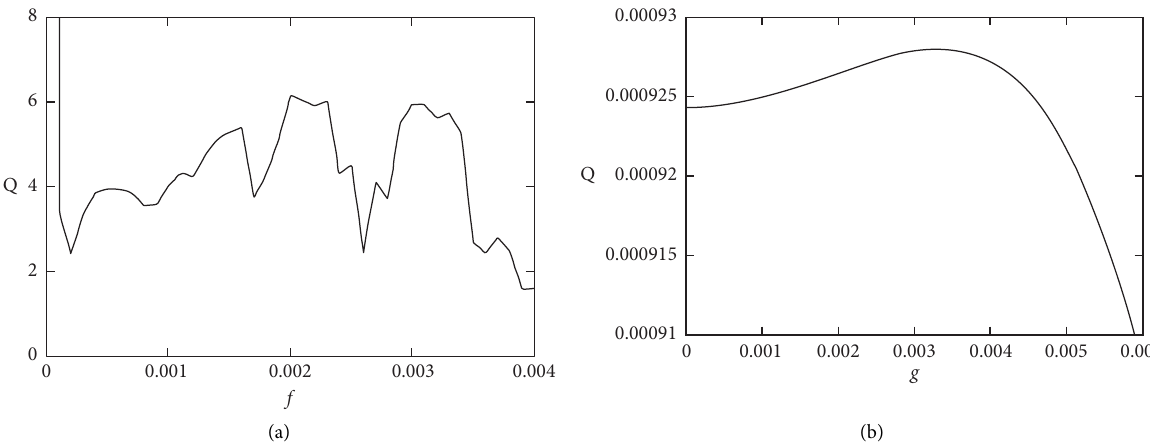
Figure 7: (a) Variation in numerically computed Q against the control parameter f with ω � 0.0481, α � 0.0413, β � 0.0667, and g � 0; (b) variation in numerically computed Q against the control parameter g with ω � 0.0481, Ω � 80 ω , α � 0.0413, β � 0.0667, and f � 0.